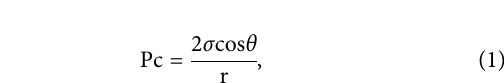
Frontiers in Earth Science |